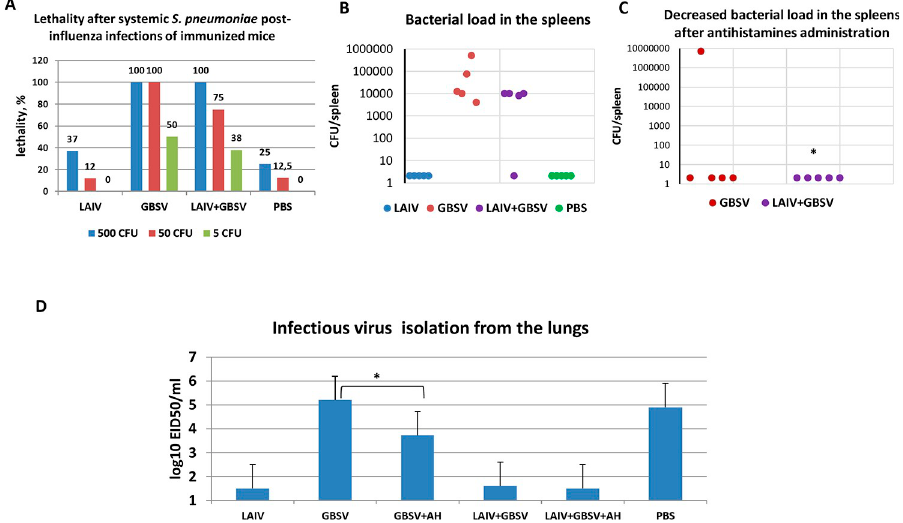
Fig 6. Intranasal challenge of immunized mice with A/Shanghai/2/2013(H7N9) CDC-RG followed by parenteral super-infection 24 hours apart with S . pneumoniae serotype 19F. (A) Lethality at 24 hours after parenteral post- influenza infection with different doses of pneumococci in groups of immunized mice (n = 8). (B) Bacterial load in the spleens 48 hours after post-influenza parenteral pneumococcal infection with 325 CFU (n = 5). (C) Decreased bacterial load in the spleens after antihistamines (AH) administration (n = 5). � - P = 0.036 compared to pneumococcal titers with no AH administration. (D) Infectious virus isolation from the lungs (“AH” means antihistamine